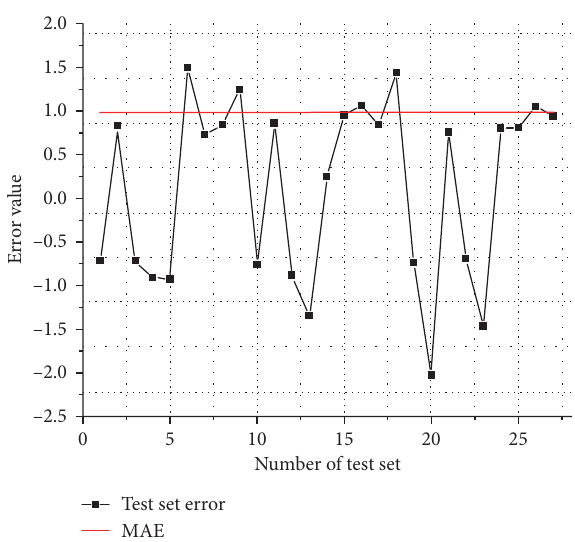
Figure 6: Prediction error trend of the LSTM